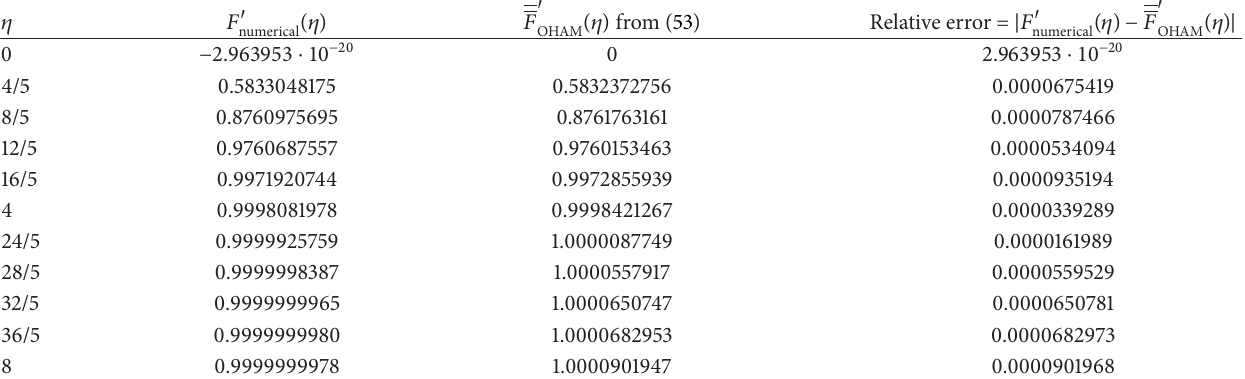
󸀠 (𝜂) obtained from (53) and numerical results for 𝛽 = 1/2 .